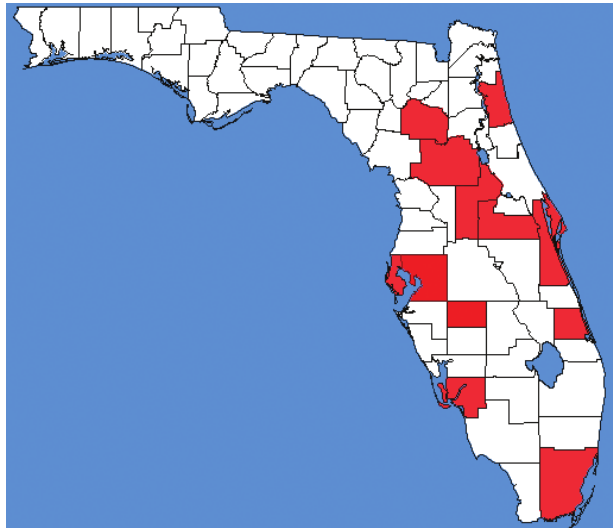
Figure 14. Distribution map indicating the counties (red) in Florida where Ps. striaticeps has been collected.